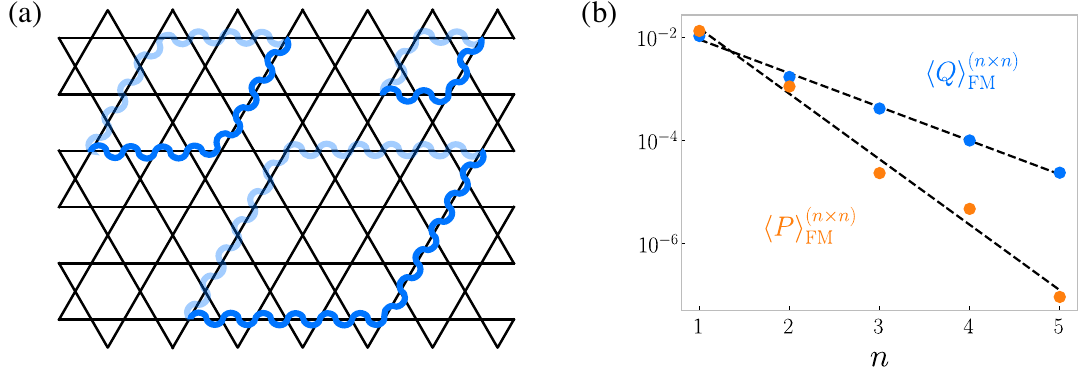
FIG. 18. The FM string order parameter in the blockade model. (a) The lattice shown is the XC-12 cylinder (periodic along the vertical direction, infinite along the horizontal direction). The blue lines denote the Q strings defining the FM order parameter h Q i ð 2, 3), which is normalized by the square root of the closed string [see Fig. 5(c) for the general definition]. (b) Values for the FM order parameters in the blockade model on XC-12 deep in the spin liquid, δ = Ω ¼ 1 . 7 . Both strings decay to zero exponentially with the length of the string, a property that is unique to the deconfined phase.